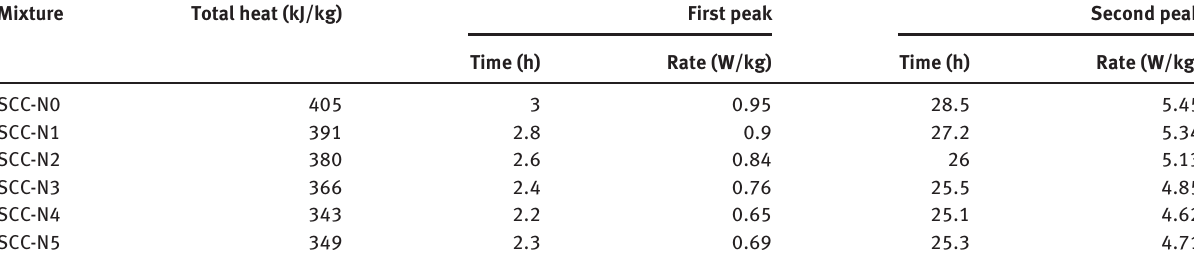
Table 5 Calorimetric results of SCC specimens.